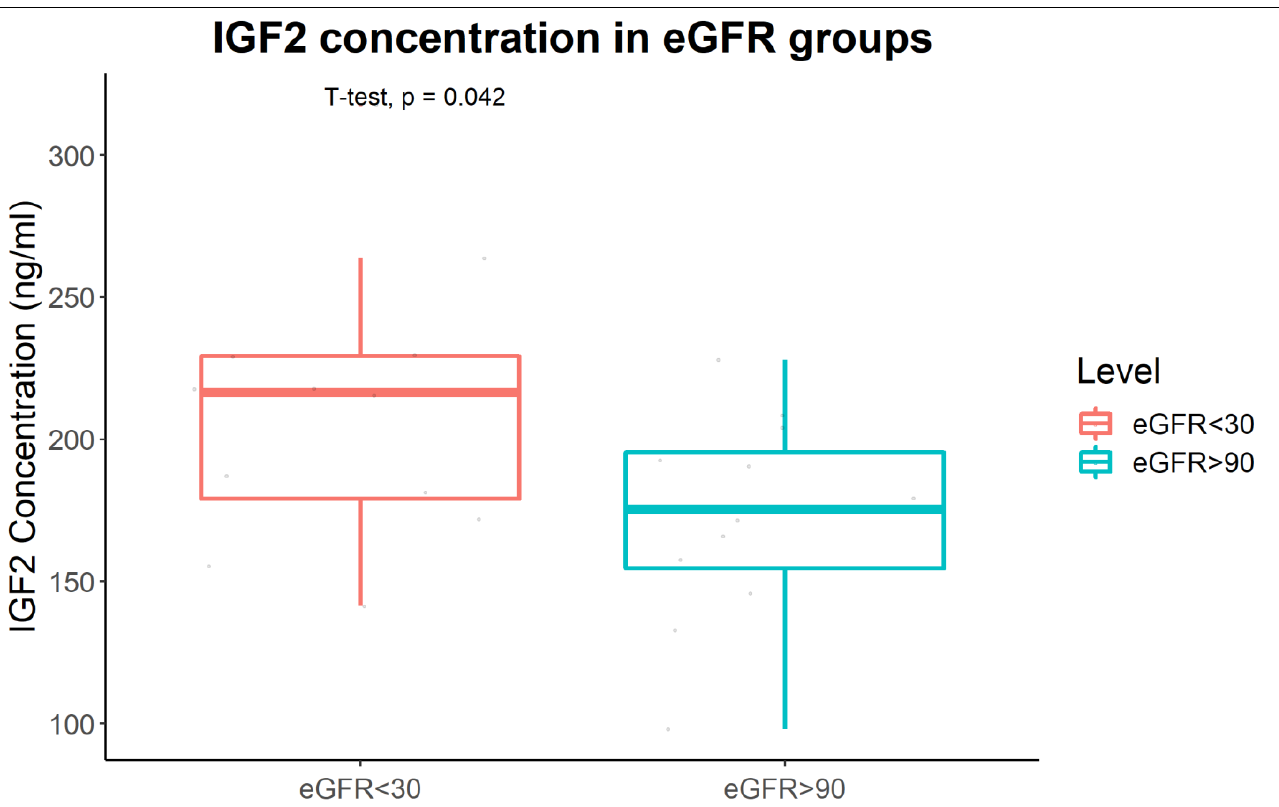
Figure 7. IGF2 protein levels in plasma of patients with eGFR < 30 mL/min/1.73 m 2 in comparison to individuals with eGFR > 90 mL/min/1.73 m 2 quantified by ELISA and depicted by a Box-Whisker plot.